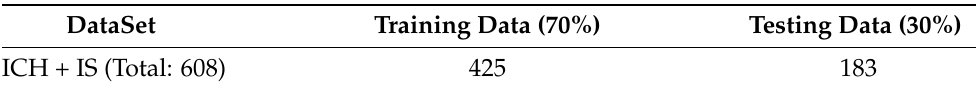
Table 2. Description of the training set and test